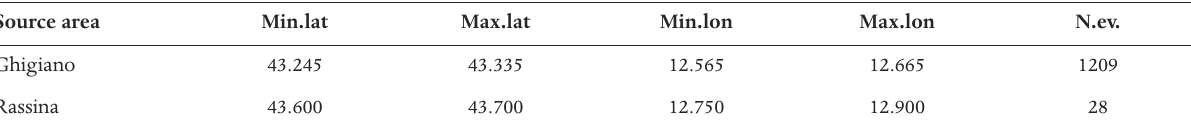
Table 2. Source areas of other non-tectonic seismic signals identified in this work. Coordinates are reported in fractional degrees of latitude and longitude. Last column: number of events assigned to each